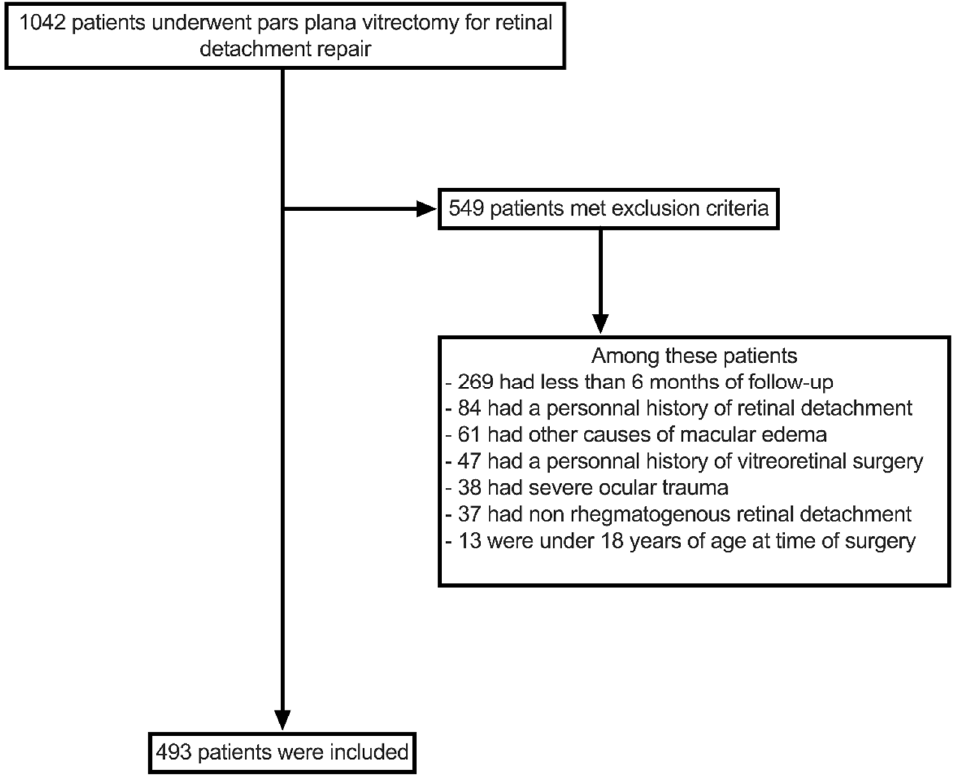
Figure 1. Flowchart of patient selection process. Table 1. Population description.